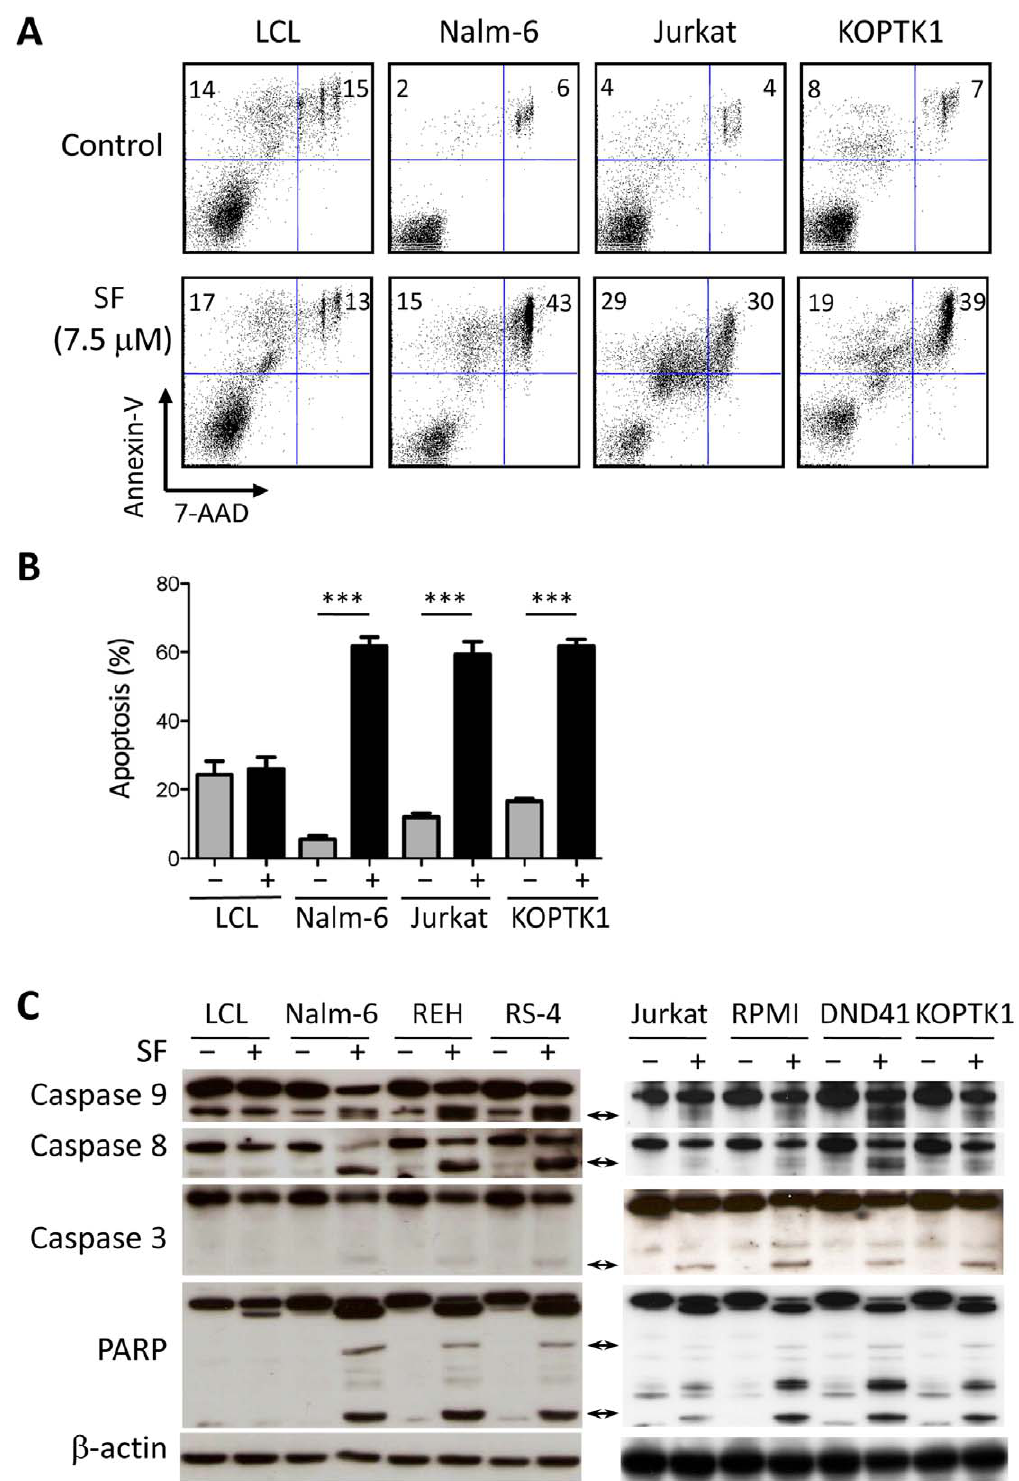
Figure 2. SF induces apoptosis selectively in ALL cell lines. (A) Apoptosis was evaluated by annexin-V and 7-AAD staining of LCL, Nalm-6, Jurkat and KOPTK1 cells cultured in the absence or presence of 7.5 m M SF. The data are representative of three independent experiments. (B) The percentages of annexin-V-positive cells were determined for each cell line cultured in the presence or absence of SF. (C) SF activates the proteolytic cascade of caspases and PARP in leukemic cells. LCL cells (control), pre-B ALL cells (Nalm-6, REH, and RS-4), and T-ALL cells (Jurkat, RPMI, DND41, and KOPTK1) were incubated with 7.5 m M SF for 24 hours and analyzed by immunoblotting. The arrows indicate the cleaved forms of the caspases and PARP. b -actin was used as a loading control. The data represent the mean and standard deviation (n=3). *** P , 0.001 (two-tailed Student’s t -test).